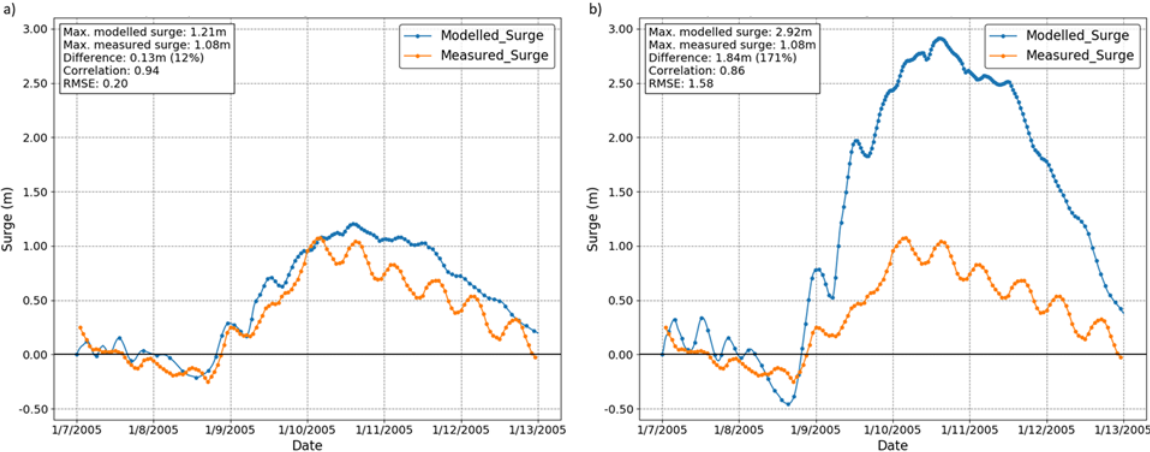
Figure 12. Comparison of the modelled and measured storm surge elevations at Station 6485 for the January 2005 storm surge event under ( a ) actual ice conditions and ( b ) a future open-water scenario.